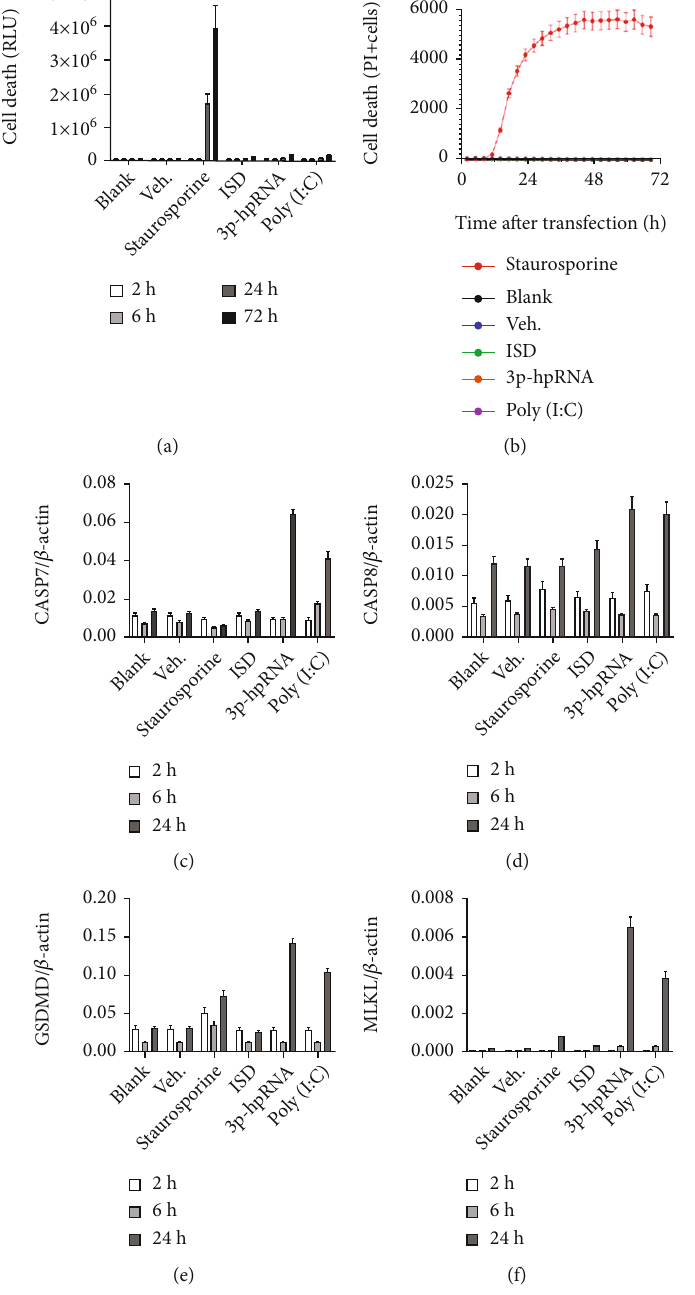
Figure 6: Nucleic acids do not induce RPE cell death but increase pro-cell death pathway genes. (a, b) Cell death in nucleic acid-transfected iPS-RPE cells (iCell) was measured by CytoTox-Glo (a) or propidium iodide (PI) staining (b). Staurosporine (10 μ M) was used as positive control to induce apoptosis. None of the tested nucleic acids (1 μ g/mL) induced RPE death. (c – f) Cell death pathway-relevant genes CASP7, CASP8, GSDMD, and MLKL were measured by qPCR in iCell at indicated times after transfection of nucleic acids (1 μ g/mL). 3p- hpRNA and poly(I:C), but not ISD, induced upregulation of pro-death